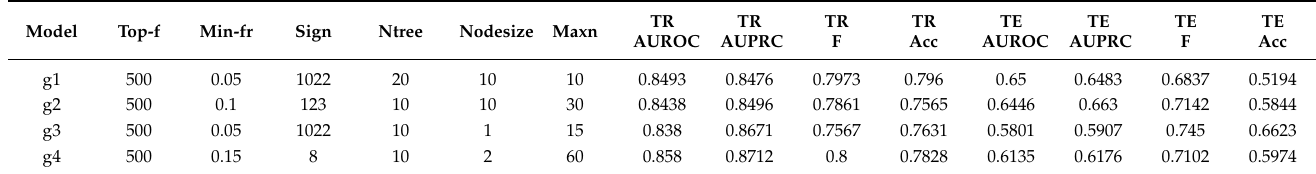
Table 2. Best random forest models trained on the genotypic data.